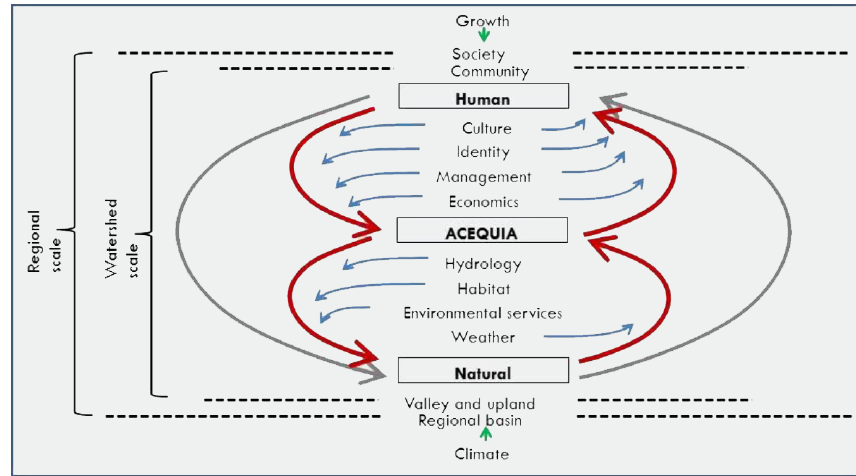
Figure 1. Acequia irrigation centered connections of human and natural systems (Fernald et al., 2012).